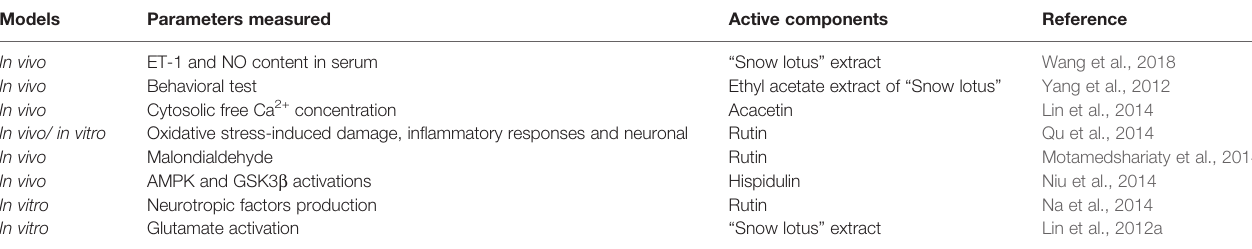
TABLE 1 | Summary of neuro-protection functions of “ Snow lotus ” and/or its major biochemical. Models